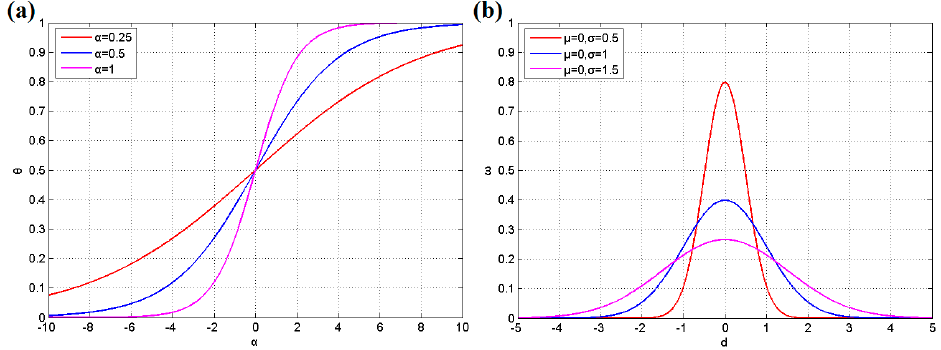
Figure 4. ( a ) Function graph of Equation (3); and ( b ) function graph of Equation (15).